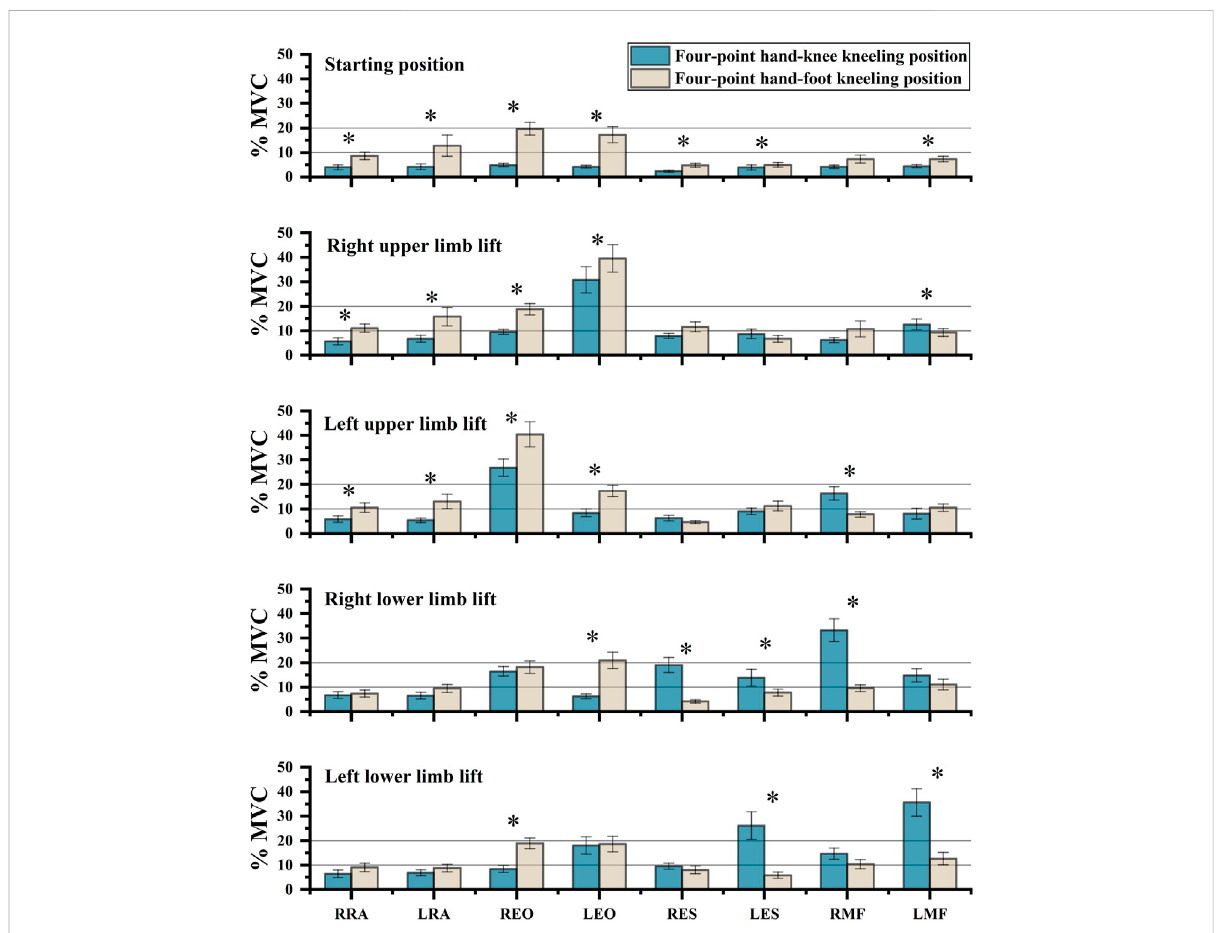
FIGURE 3 Comparison of sEMG values between the four-point hand − knee and hand − foot kneeling positions with the same limb lifted. RRA, right rectus abdominis; LRA,leftrectus abdominis; REO,rightexternal oblique; LEO, leftexternal oblique; RES,righterector spinae;LES,lefterectorspinae; RMF, right lumbar multi fi dus; LMF, left lumbar multi fi dus. *: statistically signi fi cant, p <